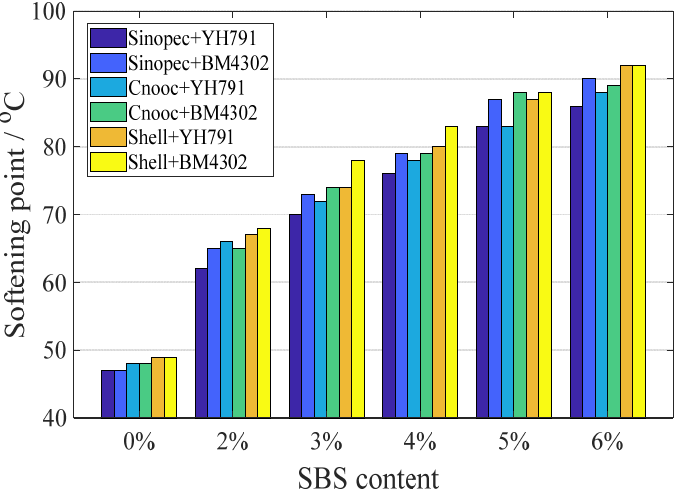
Figure 3. Softening point of all samples.